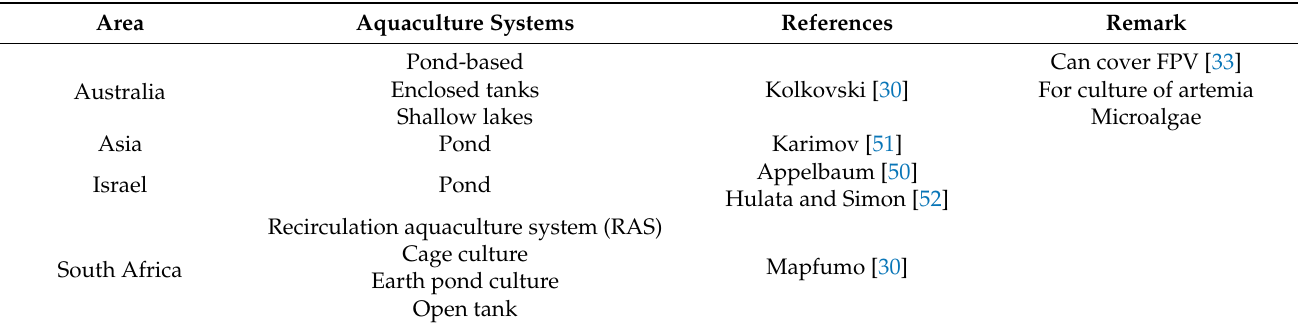
Table 2. Aquaculture systems in the desert.